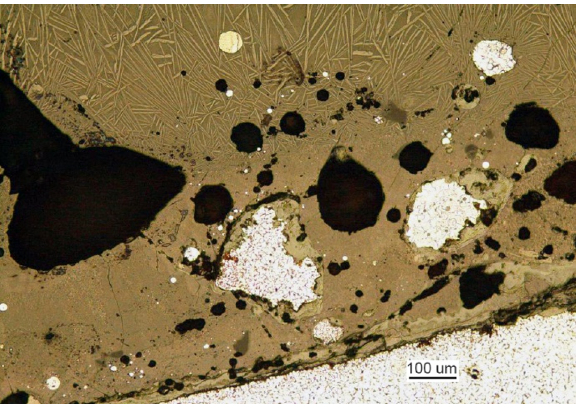
Figure 18. Fragment of the metallurgical inclusion that initiated crack 2 (handy-size bulk carrier 30206 DWT). Stereoscopic optical microscopy.